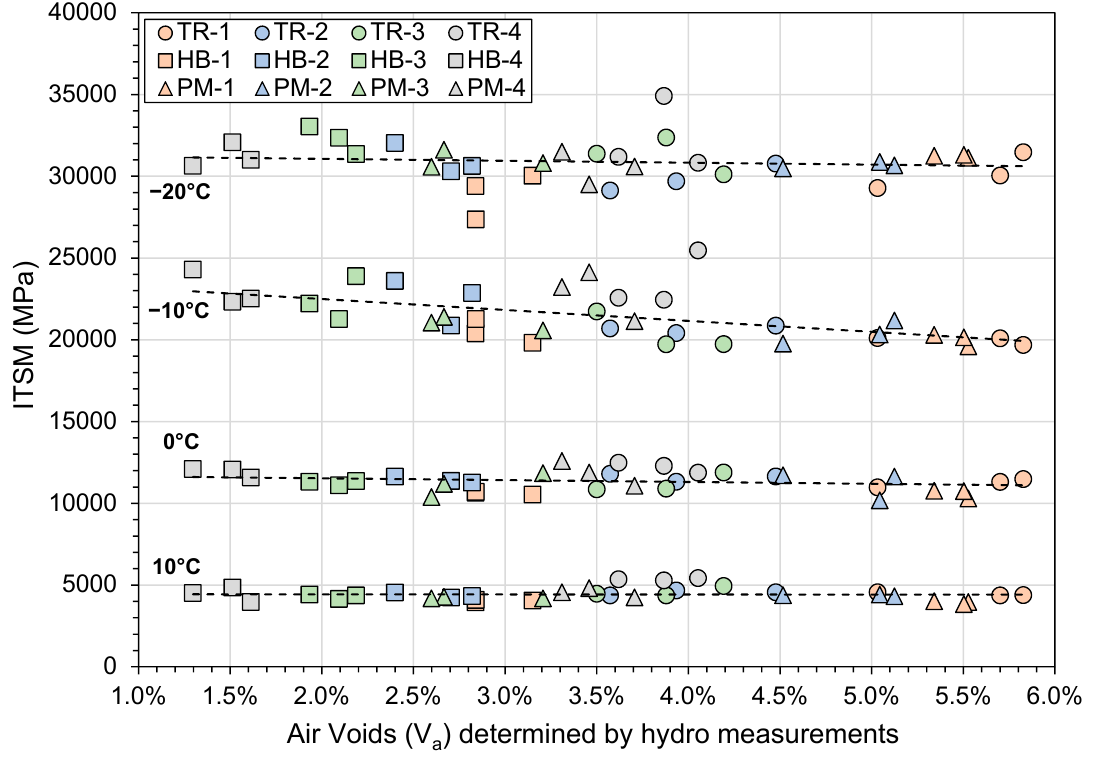
◦ C in the function of the air voids (n = 3 for each Figure 10. ITSM results at − 20, − 10, 0, and 10 °C in the function of the air voids (n = 3 for each mixing Figure 10. ITSM results at − 20, − 10, 0, and 10 mixing condition and thus, n = 36 for each temperature).